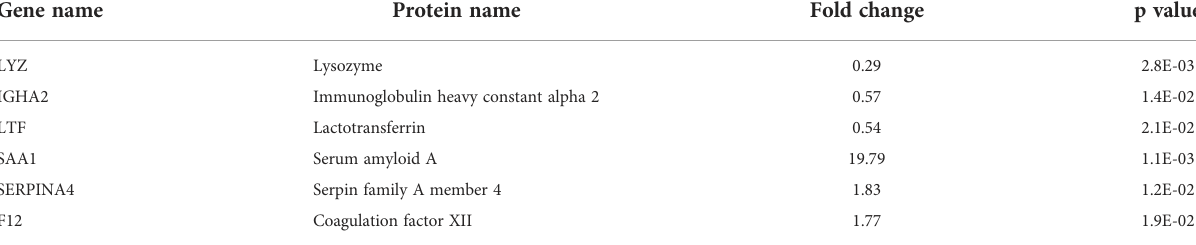
TABLE 5 Expression data of 6 candidate protein markers for diagnosis of advanced